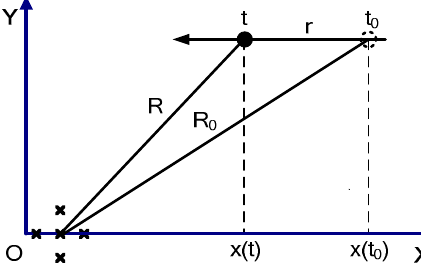
Figure 9. Path of motion of the sound source.